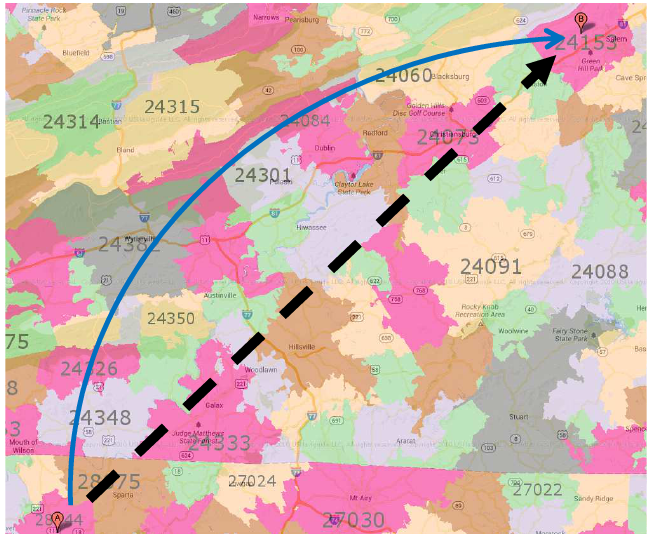
Figure 13. Example of heuristic proximity